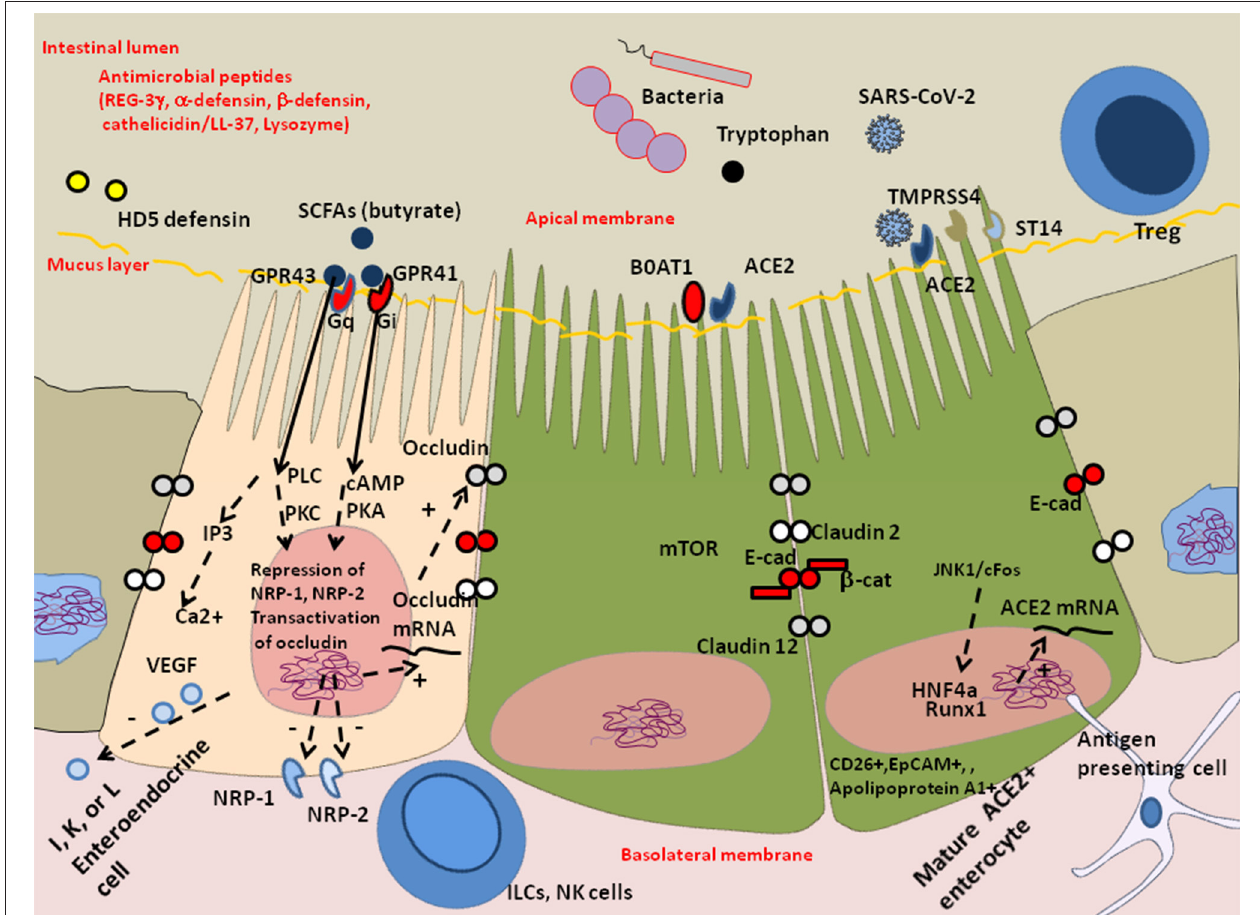
FIGURE 4 | Schematic representation of the protective effect of butyrate against dysbiosis and its proinflammatory effects. The enteroendocrines I, K, and/or L epithelial cells express heterotrimeric guanine nucleoside-binding protein (G-protein) coupled cell surface receptors (e.g., FFA2/GPR43 and FFA3/GPR41) that bind the short-chain fatty acids (SCFAs) and trigger signal leading to the regulation of the glucose homeostasis and the secretion of hormones influencing appetite. These cells also express the NRP-1 expected to enhance SARS-CoV-2 infectivity and produce the vascular endothelial growth factor (VEGF) involved in the permeability of the capillary system. In COVID-19 patients, the decreased microbiota diversity probably influence the production of SCFAs acting on enteroendocrine cells through G-protein-coupled receptor that secrete bioactive compounds. In particular, the absence of cross-feeding bacteria that help maintain butyrate production by butyric acid bacteria can aggravate intestinal inflammation, tissue damage, translocation of toxins and pathogens. Besides being a major source of energy allowing cells to escape autophagy, butyrate acts on the epigenetic regulation of genes by inhibiting histone deacetylase (HDAC), it represses NRP-1 and NRP-2 expression and increases expression of junctional adhesion molecules occludin. Symbols: ( + ) means activation; (–) means: